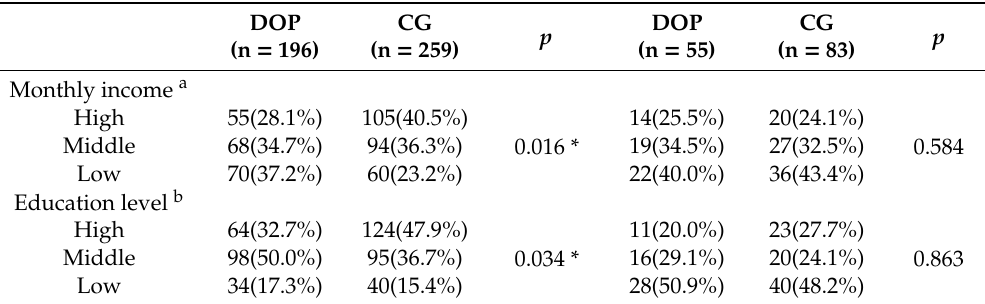
Table 3. Socioeconomic status comparison between cardiac rehabilitation dropout patients and complete patients.